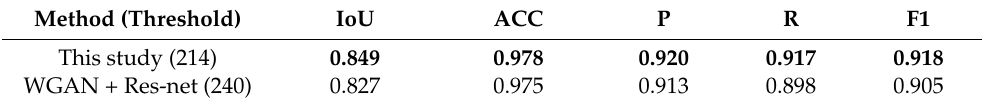
Table 1. The scores of binary results (bold denotes the high values).